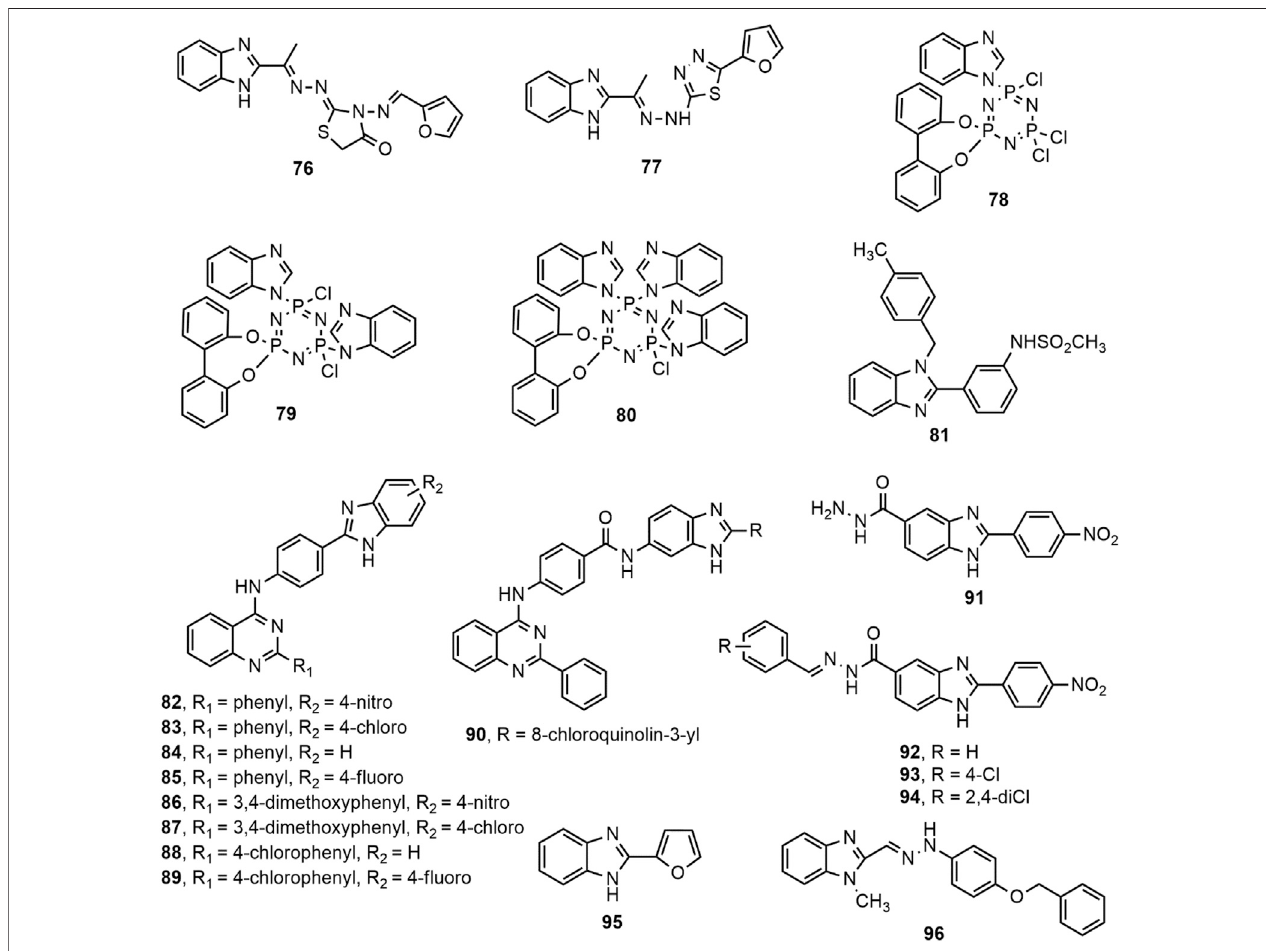
FIGURE 3 | Benzimidazole derivatives with antimicrobial